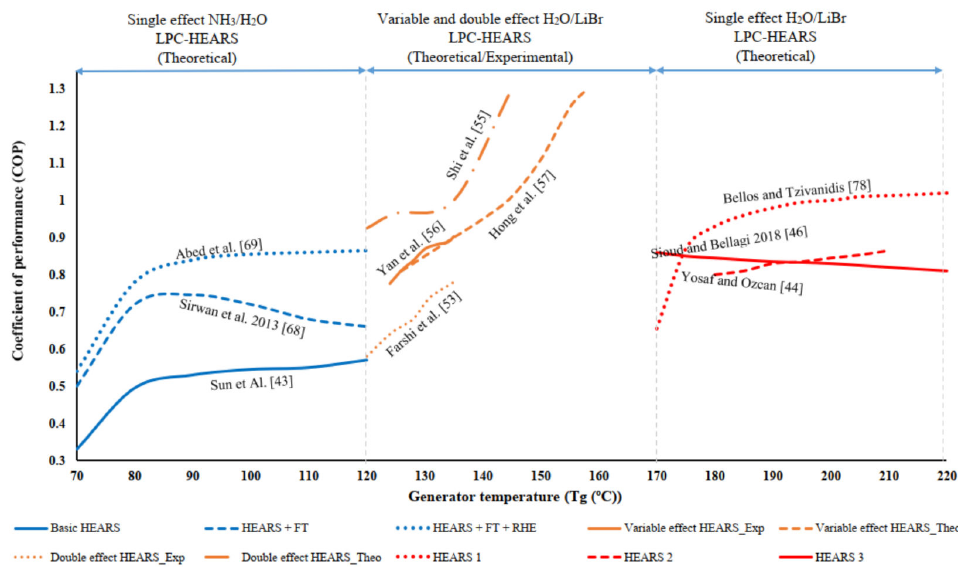
Figure 17. Change of the Coefficient of Performance (COP) with generator temperature (T g ( ◦ C)) for different HEARS’